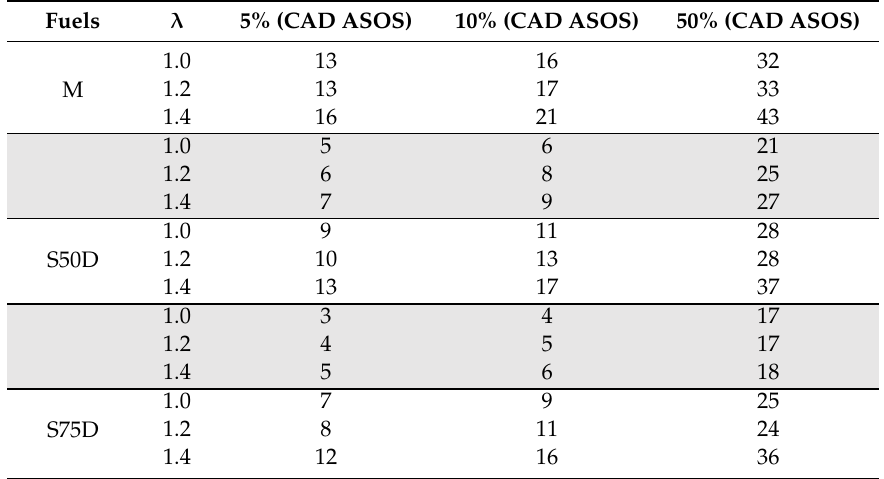
Table 4. Mass fraction burned position for combustion ignition, kernel development and main phase with respect to the start of spark.